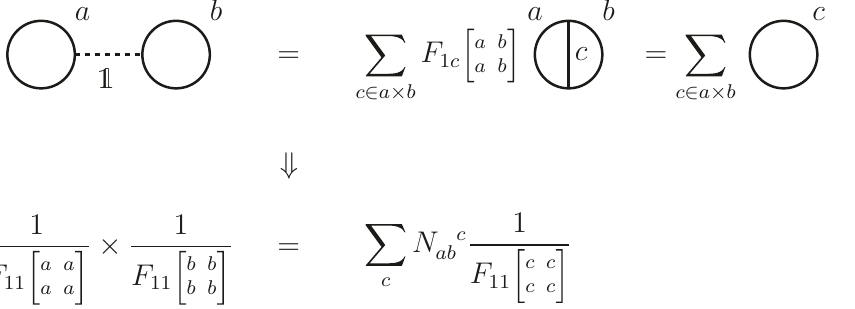
Figure 7 . Derivation of the Verlinde-like formula. In the second step we use the S 3 symmetry of the bubble factor θ ( a, b, c